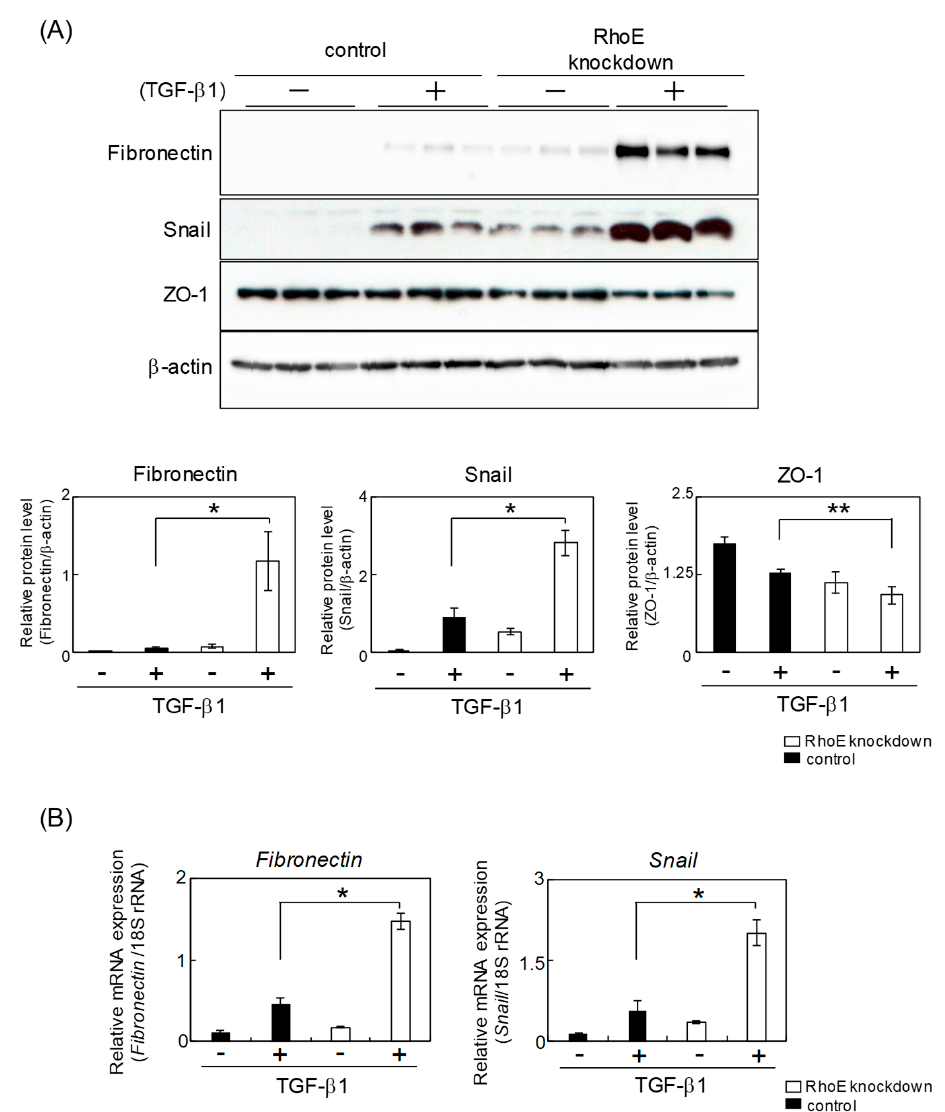
Figure 3. Knockdown of RhoE expression changes the expression levels of EMT-related genes in HeLa cells. ( A ) Protein expression of fibronectin, snail, and ZO-1 in HeLa cells transfected siRhoE-A. Cells were treated with 1 ng/mL TGF- β 1 for 72 h. Whole-cell lysates were subjected to Western blot analysis and β -actin was used as a loading control. The three lanes represent triplicates using cell lysates prepared from different culture plates. Signal intensities of the proteins were quantified using NIH-Image software. Each column represents the mean and standard deviation of three independent experiments. ( B ) qPCR analysis of fibronectin and snail expression in RhoE knockdown cells. Expression levels of fibronectin and snail were normalized to 18S rRNA expression. Each column represents the mean and standard deviation of three independent experiments. Statistical significance was assessed using one-way ANOVA with a post hoc Tukey–Kramer HSD test. * p < 0.01 and ** p < 0.05.